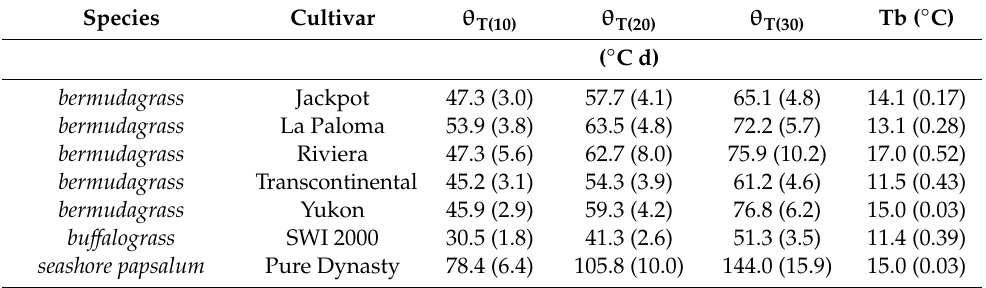
Table 3. Thermal-time parameters of seven cultivars of warm-season turfgrass species as obtained by nonlinear regression (Equation (1); [27]) (standard errors are in parentheses).